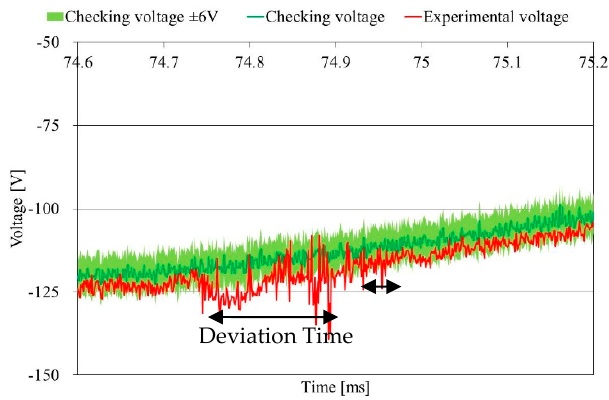
Figure 20. Magnified view of the part surrounded by a yellow ellipsoid in Figure